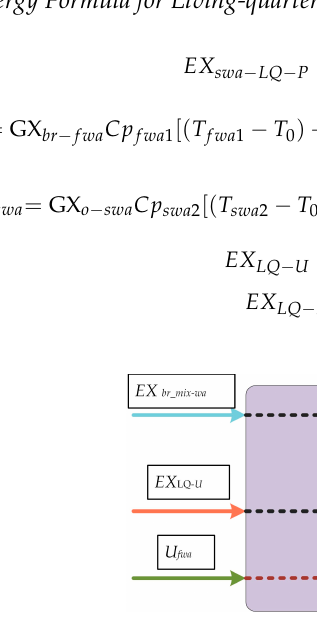
Figure A7. Process flowsheets of LQ .